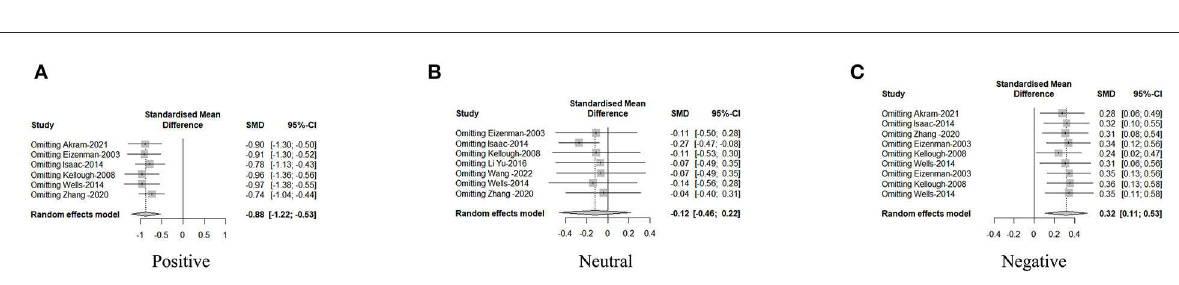
FIGURE5 Sensitivity analysis of fixation count of positive emotional stimulus (A) , neural emotional stimulus (B) , and negative emotional stimulus (C)